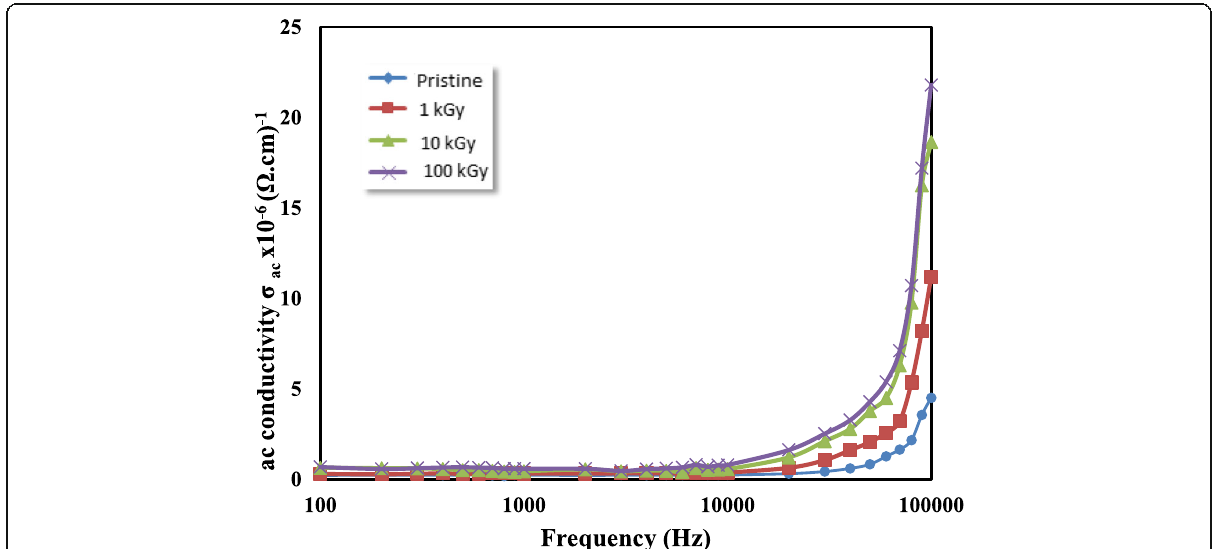
Fig. 5 Frequency dependence of the ac conductivity for the investigated samples at room temperature